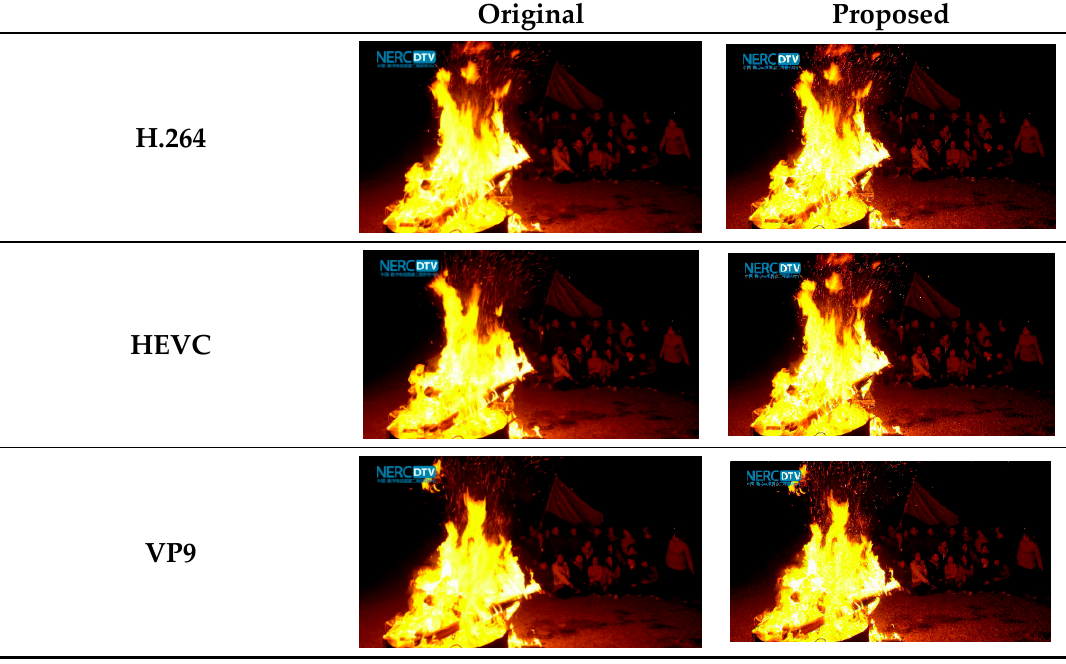
Figure 10. Subjective quality performance for the ‘Campfire’ sequence.